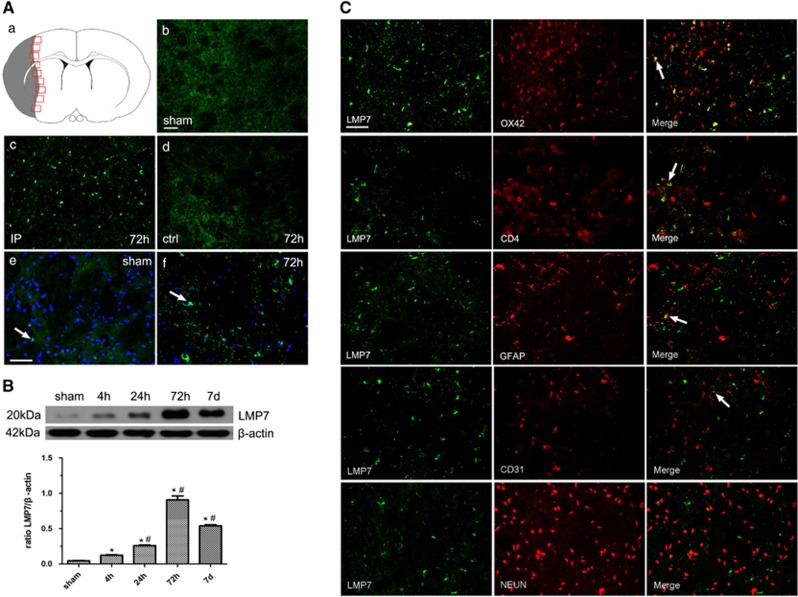
Expression and cellular localization of LMP7 in the brains of MCAO rats. (A) A schematic representation of a coronal brain section. The square fields represent observed regions (a). LMP7 signal was barely detectable in the cortex and striatum in the sham-operated animals and contralateral hemisphere in ischemic rats (b). In contrast, the LMP7 signal was evident in the ipsilateral ischemic hemisphere (c and d, 72 h time point was shown here). LMP7 was mostly present in the nucleus in non-ischemic hemisphere whereas it was evident in both the nucleus and the cytoplasm in ischemia hemisphere (arrow) (e and f). Five rats in each group were used for immunofluorescent assays (n=5). (B) Western blot confirmed that LMP7 protein levels were significantly elevated in the ipsilateral cerebral cortex and striatum at all times when compared with sham-operated control animals. Quantification analysis confirmed that the level of LMP7 protein changed from 4 h to 7 days in the ipsilateral ischemic cortex and striatum (*P<0.001, compared with the sham-operated controls; #P<0.001 compared with the previous time point) (B). Five rats in each group were used for western blot (n=5). (C) Double immunostaining indicated that LMP7 was mainly expressed in OX42-positive microglia/macrophage cells (red), some in CD4+T lymphocytes (red) and very few LMP7 in glial fibrillary acid protein (GFAP)-positive astrocytes (red) as well as CD31-positive vascular endothelial cell (red) (arrow). In contrast, LMP7 was not detected in NEUN-positive neurons (red) at any time points (C). Scale bars=80 μm (in A: b–d), 50 μm (in A: e and f, C). IP, ipsilateral hemisphere; ctrl, contralateral hemisphere; sham, sham-operated control rats